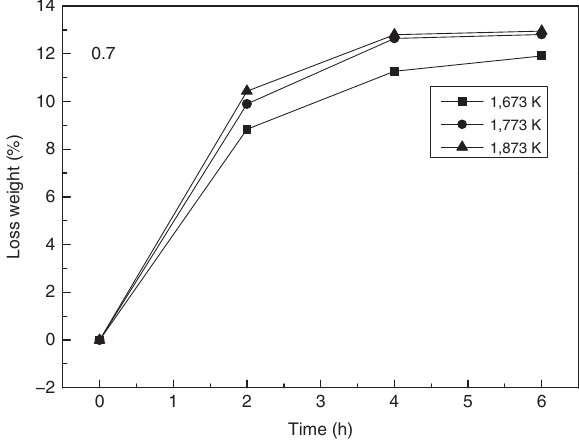
Figure 3: The percentage of total mass loss with different carbon ratios at 1 673 K.